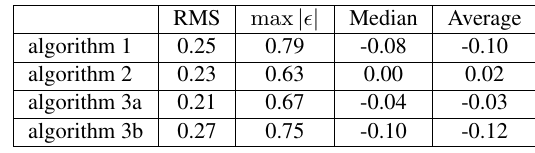
Figure 15. (a): crack width visualization with algorithm 1; (b): crack width visualization with algorithm 2; (c): crack width visualization with algorithm 3; (d): visualization of the absolute values of translations of algorithm 3